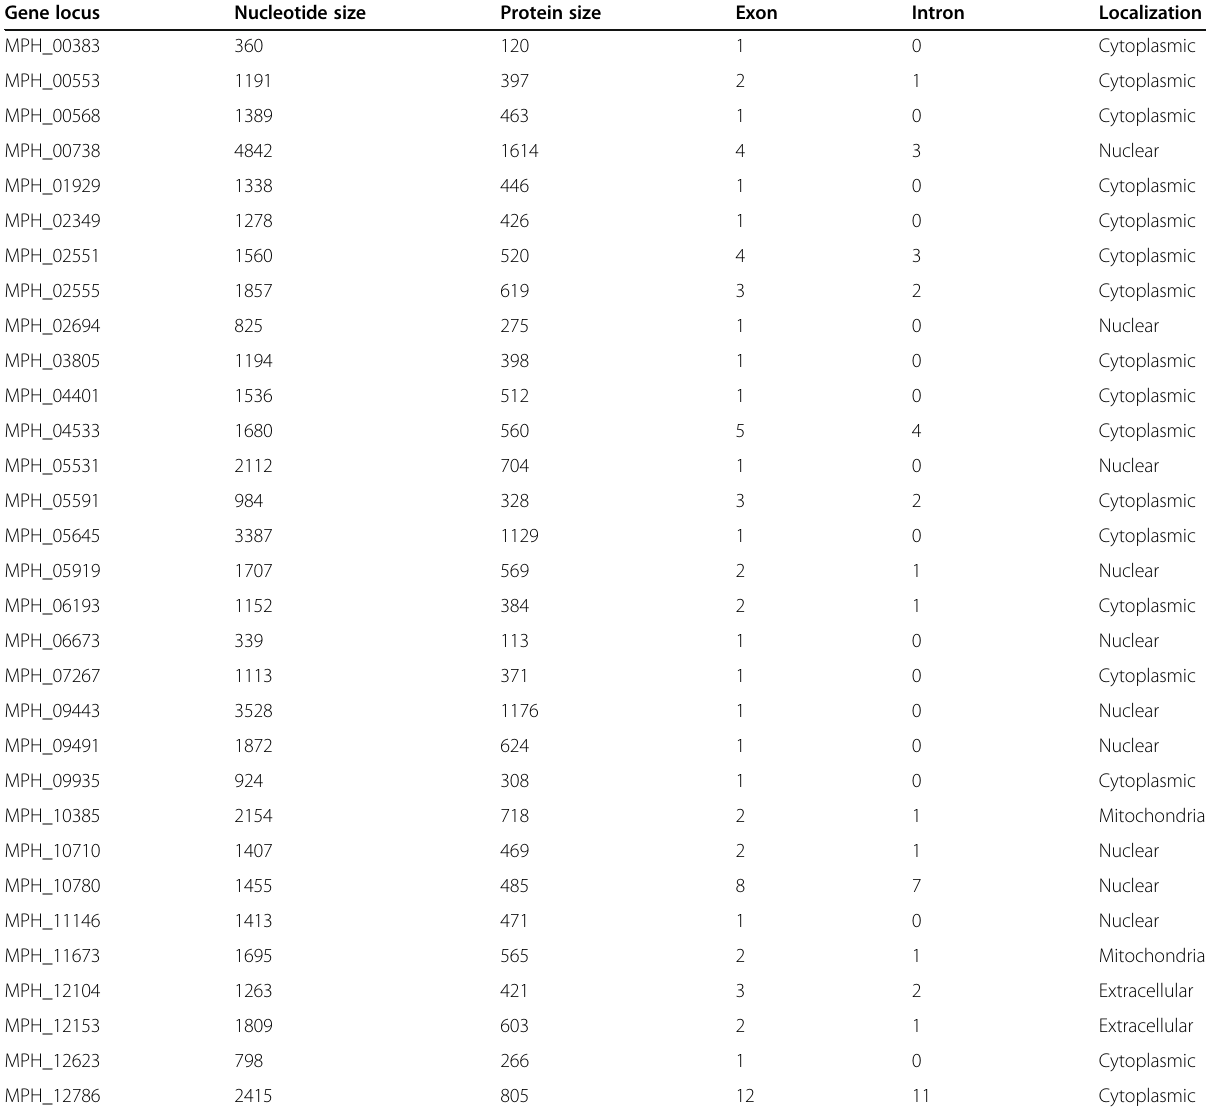
Table 2 Basic information of F-box protein in the stem rot fungus Macrophomina phaseolina Gene locus Nucleotide size Protein